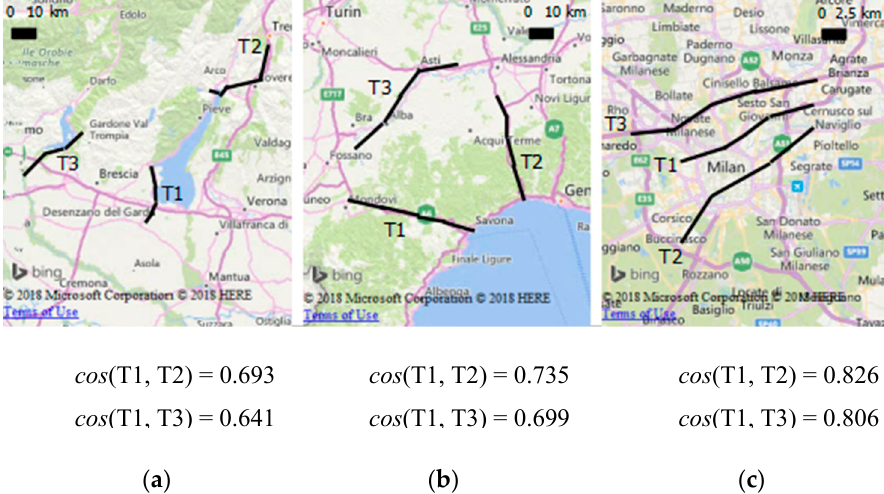
Figure 14. Three examples of traces with similar COM distances but different behavioral representation: ( a ) shows two traces (T1 and T2) near different sides of the same lake, and a third one (T3) near a different lake; ( b ) shows two traces (T1 and T2) reaching the same tract of coastline, and a third one (T3) traveling in the inland parallel to the coast; ( c ) shows two traces (T1 and T2) crossing the metropolitan area of Milan, and a third one (T3) traveling along the highway at the border of the city.